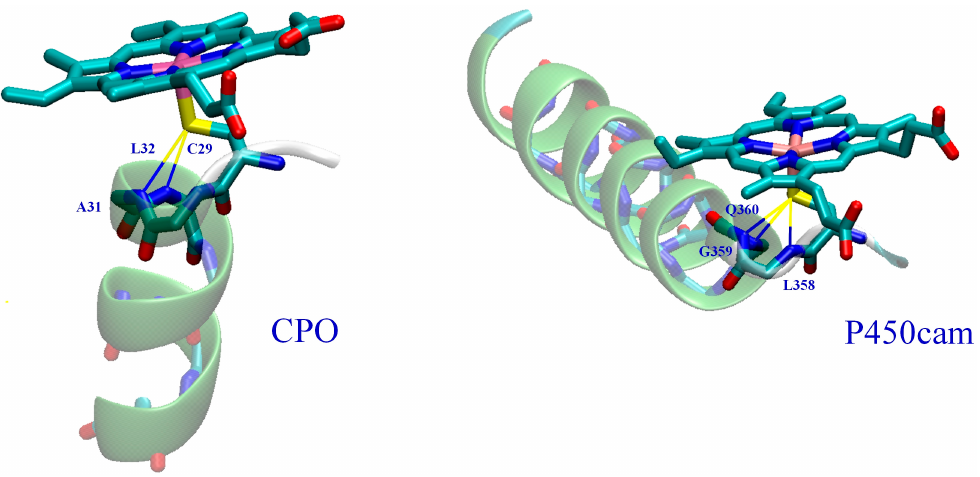
Figure 1. Proximal pockets of CPO and P450cam.